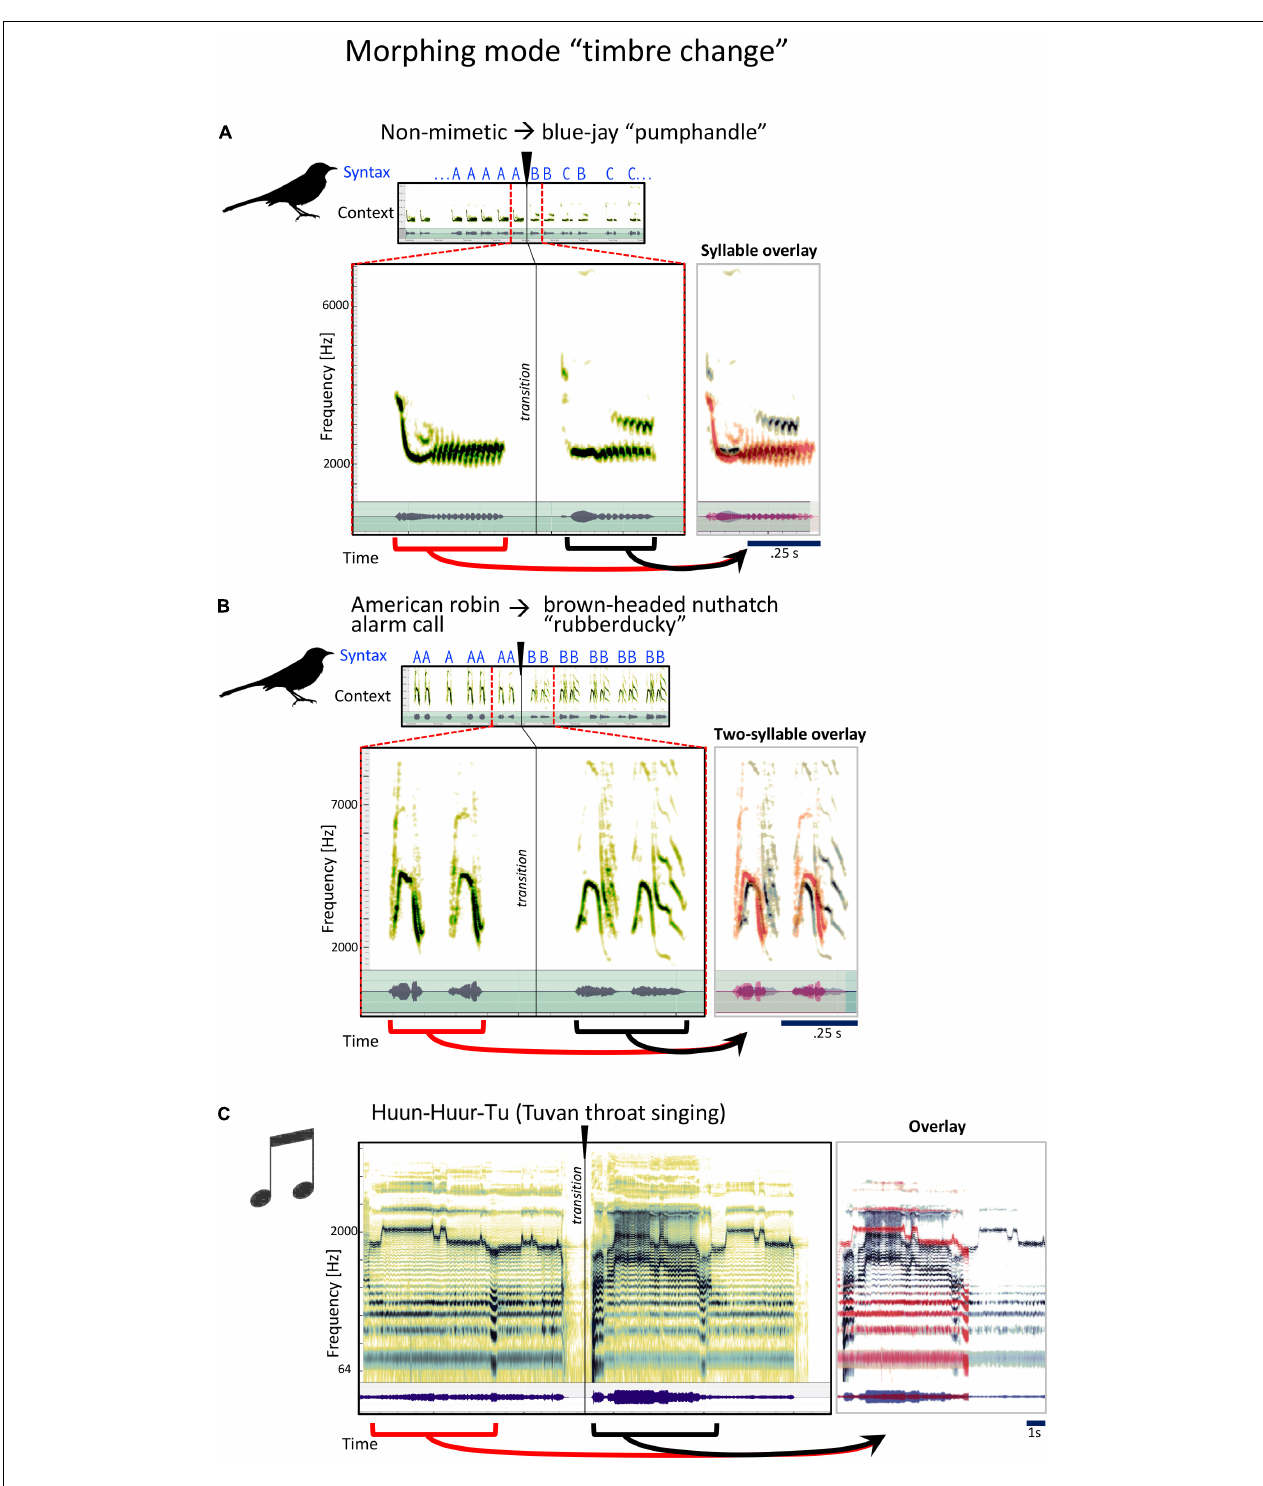
FIGURE 4 | Examples for the mockingbird morphing mode “timbre change,” and example for a similar musical strategy. (A,B) Spectrograms and waveforms for three examples of phrase transitions representing “timbre” morphing, in which a phrase is followed by a phrase with similar syllables and temporal structure, the main difference being a modification in timbre. Small spectrograms on top show the song context with a clear transition from one song phrase to a new song phrase, which is also clearly evident when listening to the song files. Large spectrograms underneath zoom in to the section around the transition. Panels to the right show an overlay of the pre-transition (red) and post-transition (gray/black) syllables. Similarities between pre- and post-transition syllables become particularly clear in the overlay pictures. (C) Similar illustration for a musical example of Tuvan throat singing from the group Huun-Huur-Tu, in which a whistling phrase (pre-transition) is picked up again (post-transition) in a different